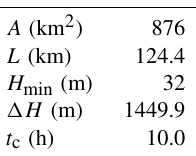
Table 1. Main hydrological characteristics of the Panaro watershed (area A , main stream length L , minimum elevation H min , elevation drop (cid:49)H , time of concentration t c